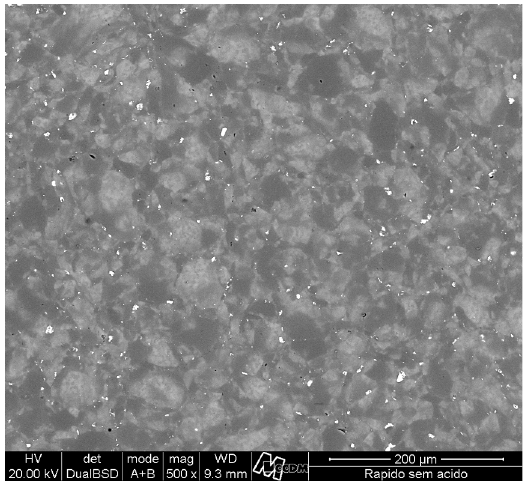
Figure 2. SEM images at 500 x magnification of Vita VM9 submitted to fast cooling.